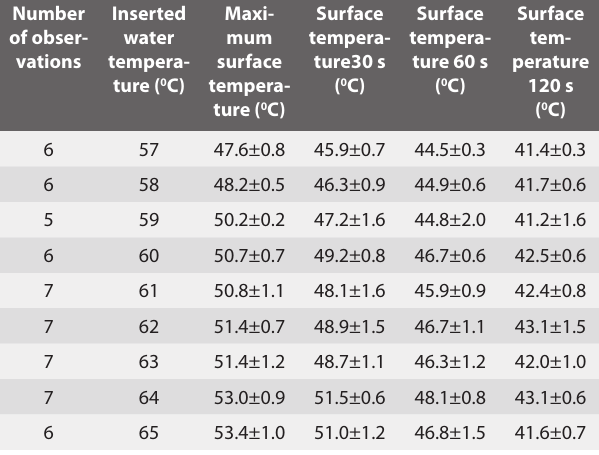
Table 1. Overview of Epistat®